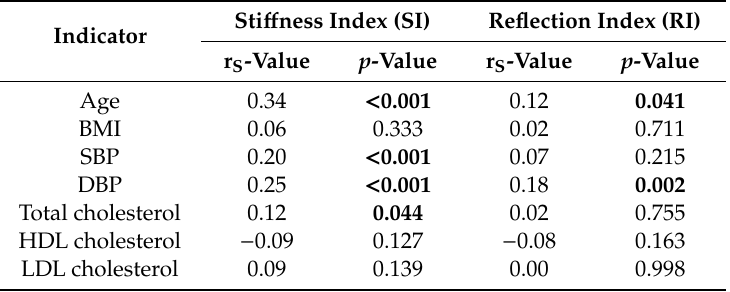
Table 4. Spearman’s correlation between arterial sti ff ness parameters and cardiovascular risk indicators. BMI = body mass index, SBP = systolic blood pressure, DBP = diastolic blood pressure; p -value < 0.05 is indicated in